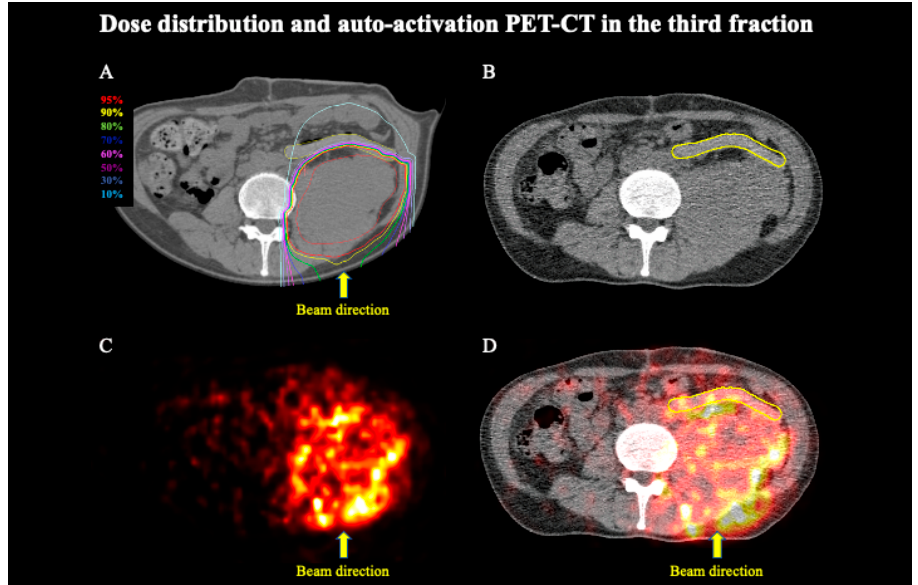
Figure 3. Dose distribution of C-ion RT and AAPET images with a 180° beam in the third fraction. ( A ) Dose distribution of C-ion RT with 180° beam. The area within the red outline is the tumor. Highlighted are the 95% (red), 90% (yellow), 80% (green), 70% (deep blue), 60% (magenta), 50% (purple), 30% (blue), and 10% (light blue) isodose curves (100% was 4.4 Gy (RBE)). ( B ) CT image simultaneously taken with the PET scan. The area within the yellow outline is the spacer. ( C ) AAPET image. ( D ) Positron emitter distributions obtained using merged CT and AAPET images. The area within the yellow outline is the spacer.